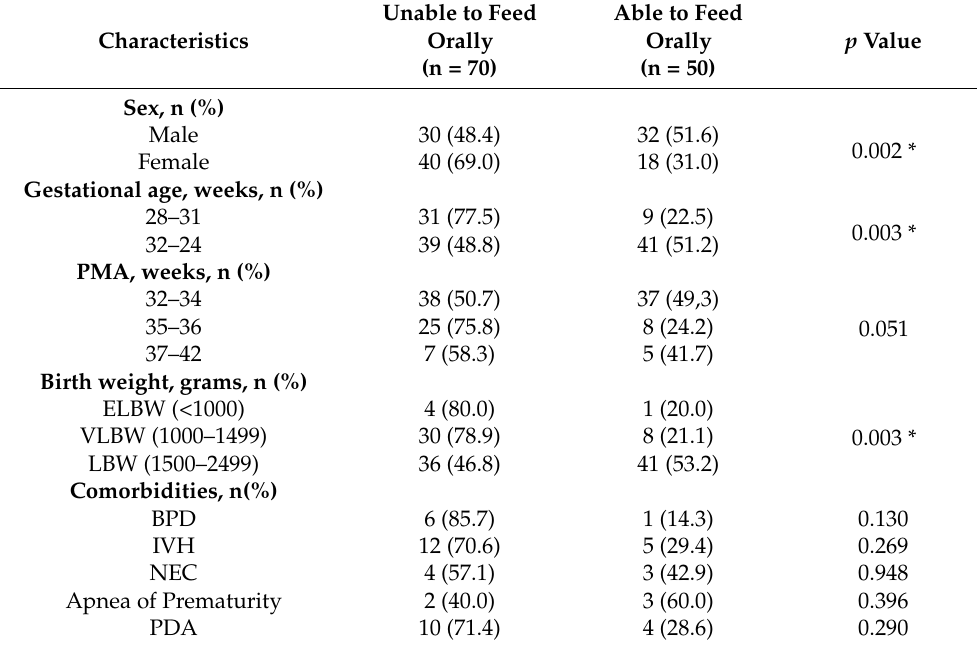
Table 1. Characteristics of Study